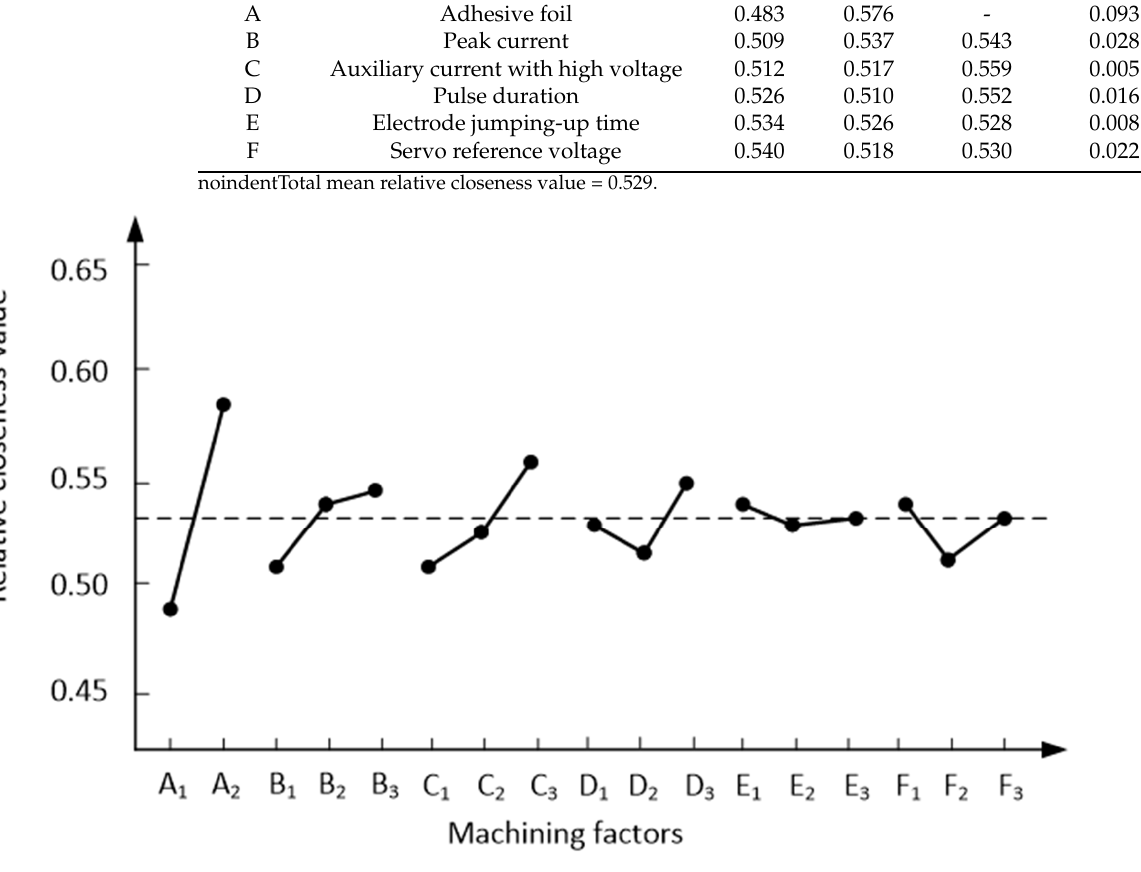
Table 13. Performance table for the relative closeness value.